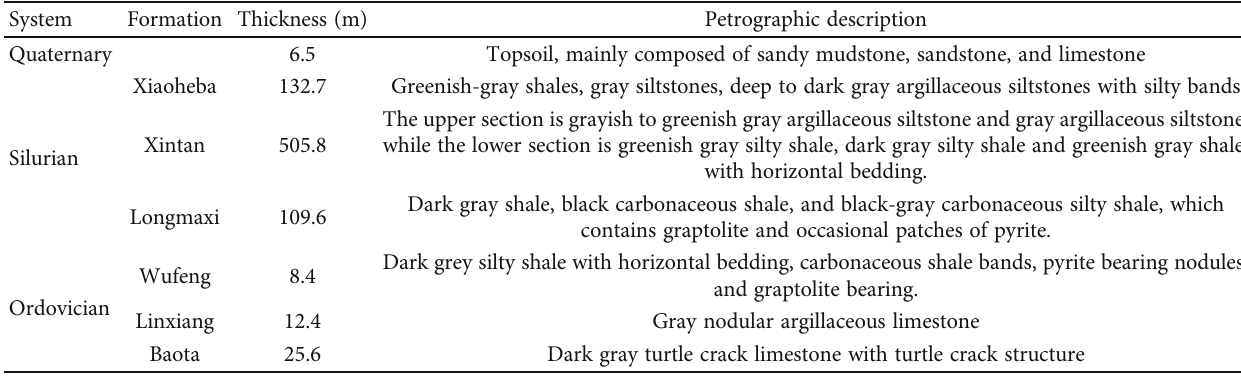
Figure 1: Regional overview of the Well-YC4 and its surrounding area [30, 36, 46]. Table 1: Brief information of the drilled strata in